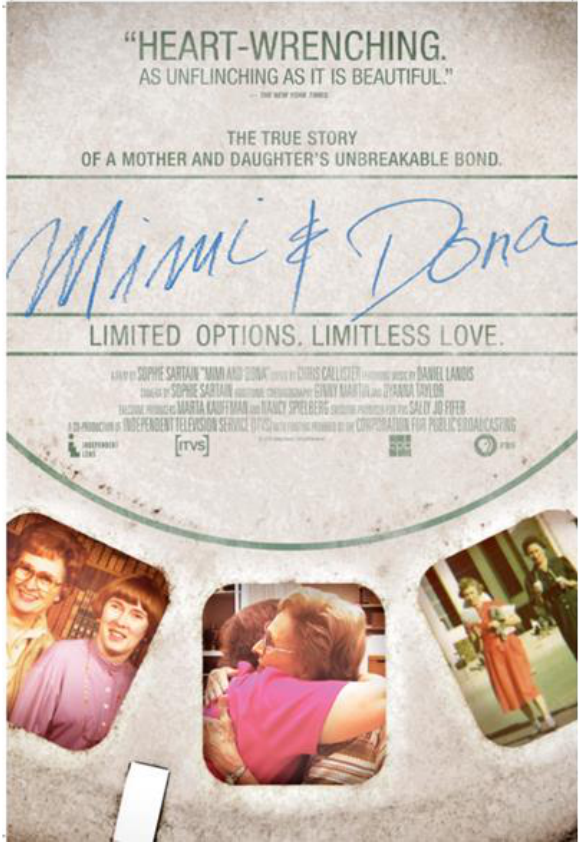
Figure 2: Poster for the film Mimi and Dona Sophie Sartain witnesses the watershed moment, that was a long time coming, when Mimi nears the end of her caregiving abilities; when Mimi too, becomes ‘disabled’ to care. More than six years after the first screening of the documentary film, I invited filmmaker Sophie Sartain to pause on the origins and her motivations, on the making of, on the ethics of representation, and on the afterlives of this